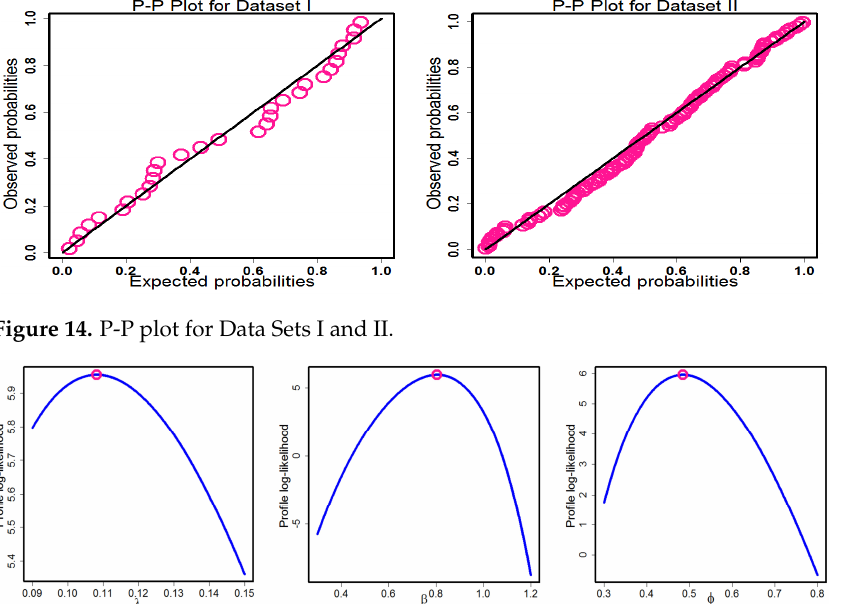
Fig. 15: Uni-modal pro(cid:133)le likelihood functions of parameters of HLUG-TI for Data I.